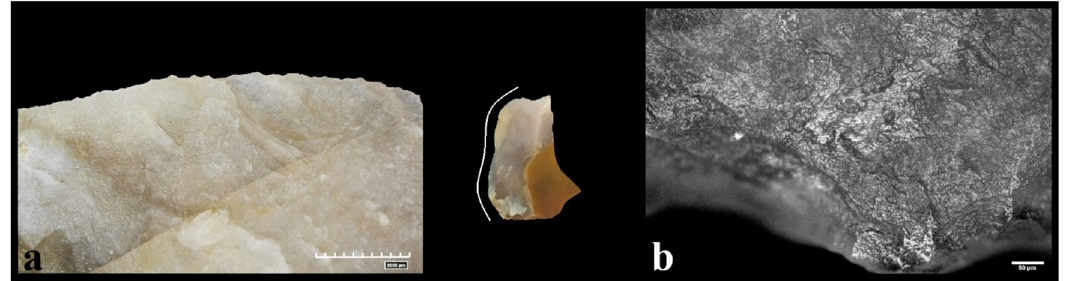
Figure 3: ( a ) Macro snap and half - moon scars and localised distribution and ( b ) greasy polish with fl at topography ( photo A. Petrovi ć ) .